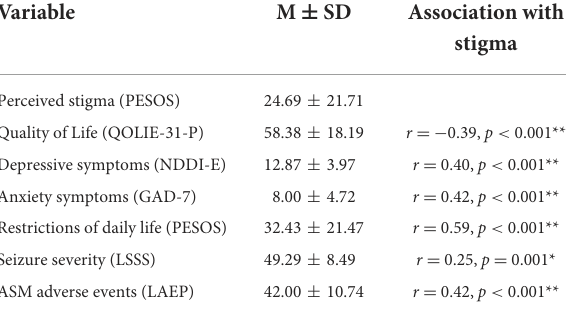
TABLE 3 Results of the multiple regression